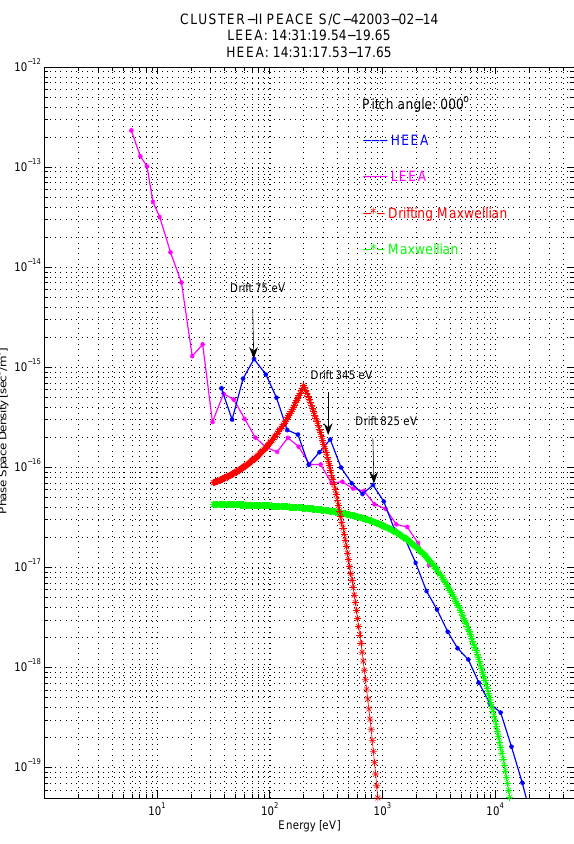
downgoing electrons from the sensors HEEA (blue line) and LEEA (magenta line). One ordinary Maxwellian distribution (green line) and one drifting Maxwellian distribution (red line) with energy of 200eV will represent typical electron populations in the theory sec-